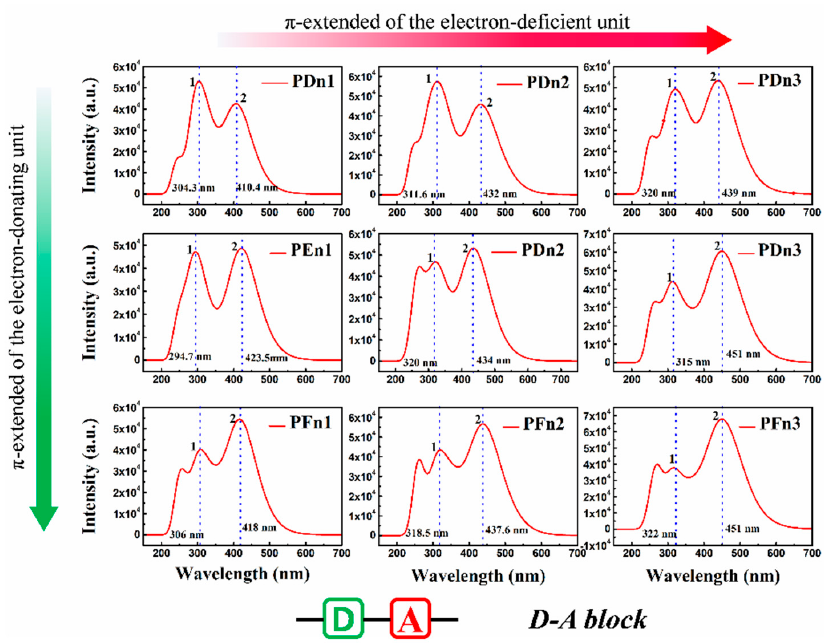
Figure 7. The simulated absorption spectrum for PDn1, PDn2, PDn3, PEn1, PEn2, PEn3, PFn1, PFn2, and PFn3. The value of the FWHM is 0.333 eV. Table 2. The table shows the absorption wavelength ( λ max ), vertical transition energies (eV), main transition contribution, the oscillator strengths ( f ) of all the molecules, the lifetime of spontaneous radiation τ (ns), and light-harvesting efficiencies (LHE). Molecule